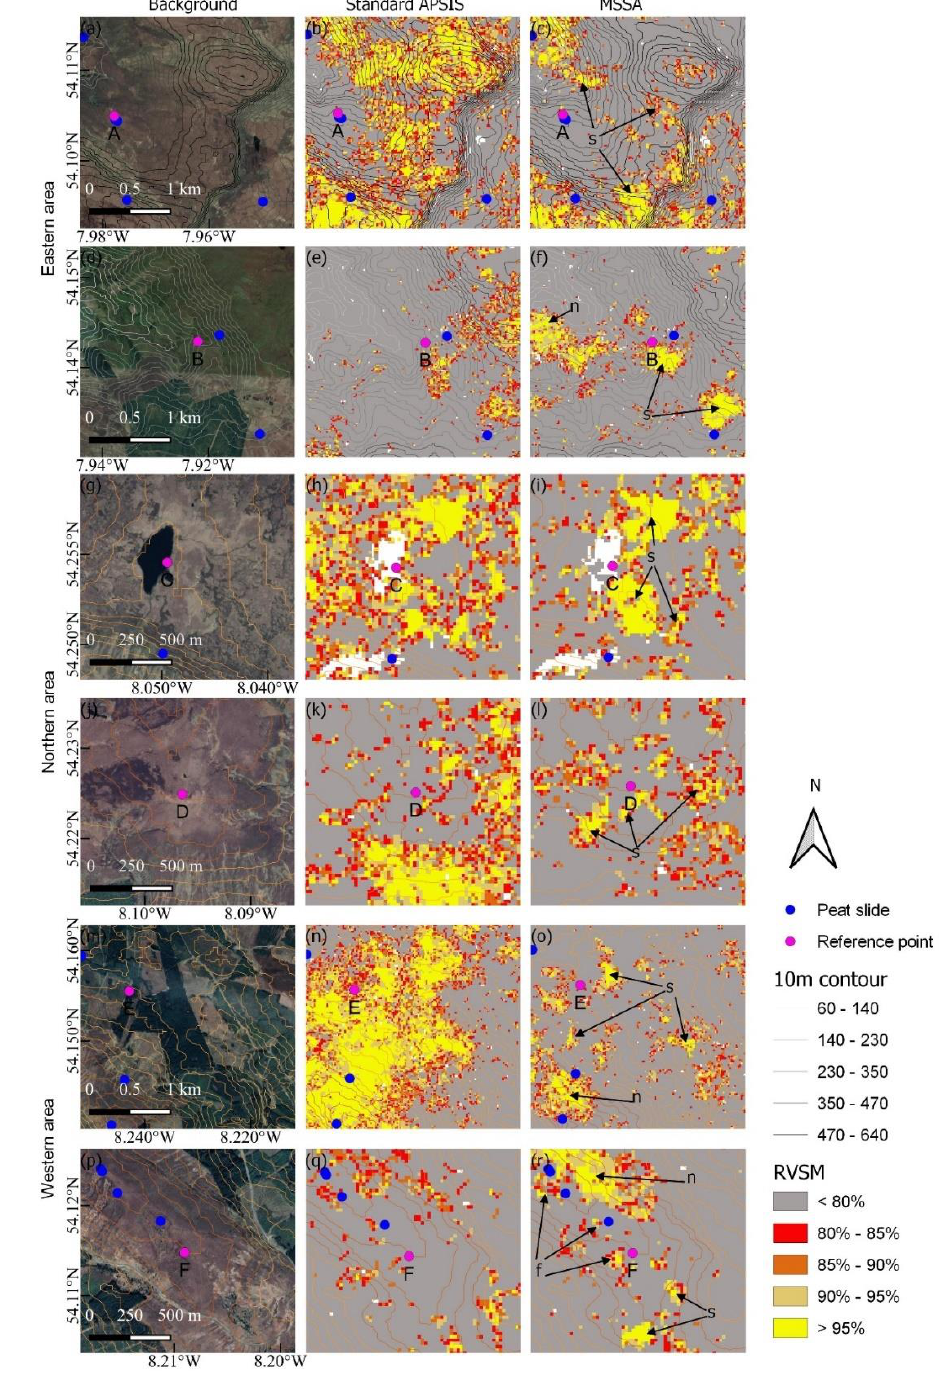
Figure 10. Examples of typical associations between areas of high RVSM and position within a blanket bog landscape. Selected features are chosen from the Eastern (a–f), Northern (g–l) and Western areas (m–r). 10 m topographic contours derived from a DEM are superposed on each image. For each example area the first column is an optical image from Google Earth, the second column is a one-year RVSM image derived from standard APSIS data and the third column is an RVSM image derived from MSSA data. The locations of reference points A–F are shown in Figure 9. Areas of known peat landslide (Geological Survey Ireland 2021) are shown as blue dots. Example landscape associations are shown for associations with seepage (s) at breaks in slope and upslope extension of drainage lines; and associated with peat landslides (f). Note that only the most obvious examples on the optical (Google Earth) image with a N to NE aspect (n) are